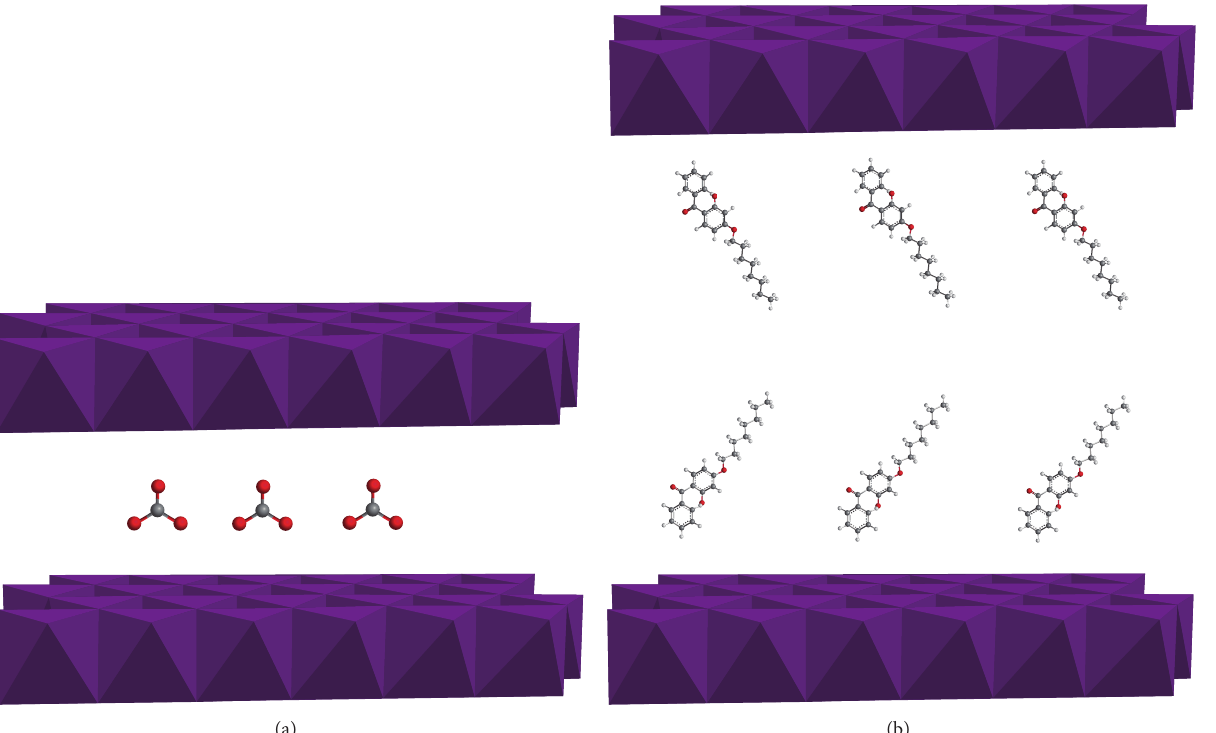
Figure 2: Schematic model of (a) Zn/Al-CO 32− -LDH and (b) Zn/Al-HNOB − -LDH.